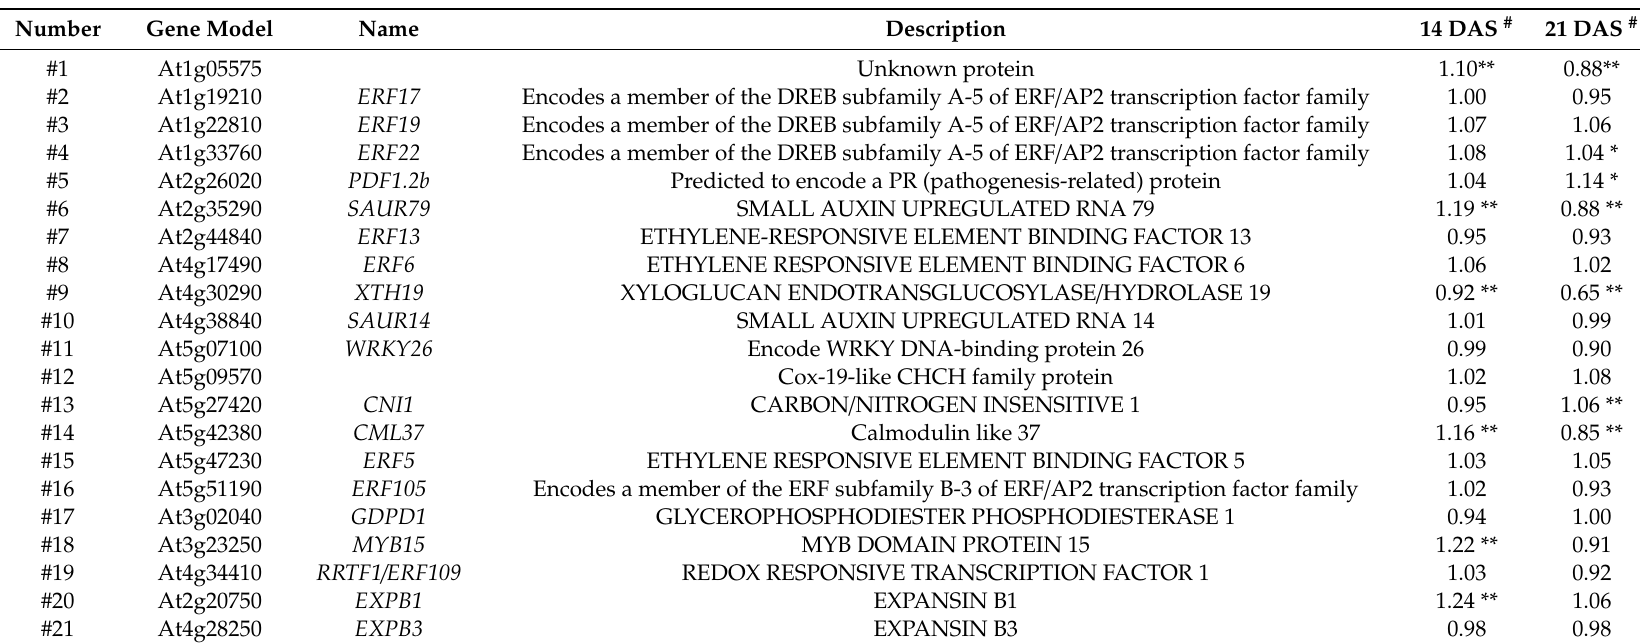
Table 2. List of genes for producing overexpressed transgenic